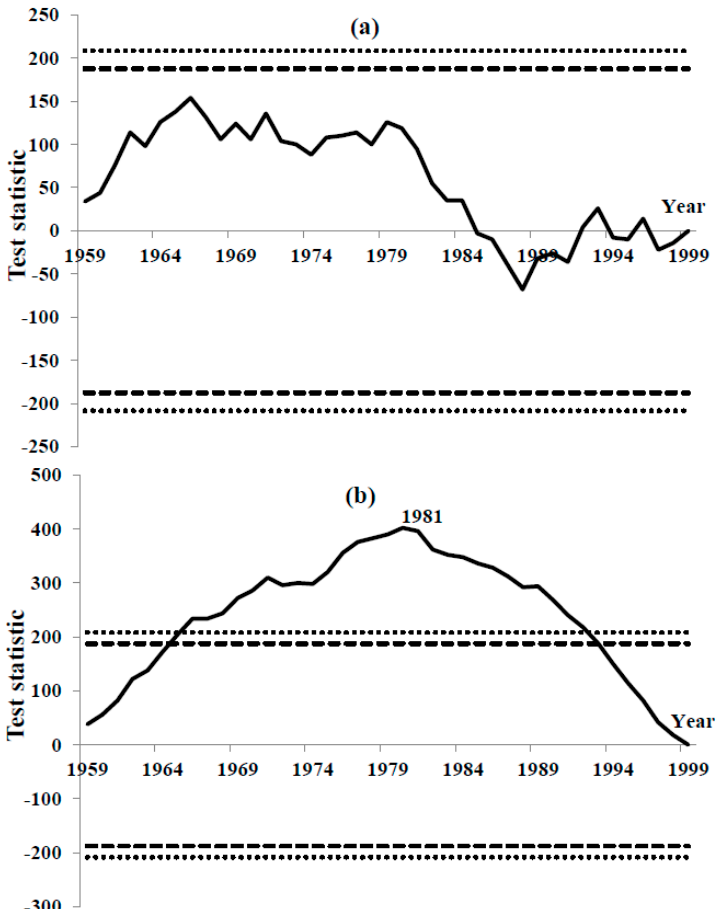
Figure 4. The annual minimum low flow change point at ( a ) Makou and ( b ) Sanshui stations. Horizontal lines represent the significance levels of 5% (dotted) and 10% (dashed).